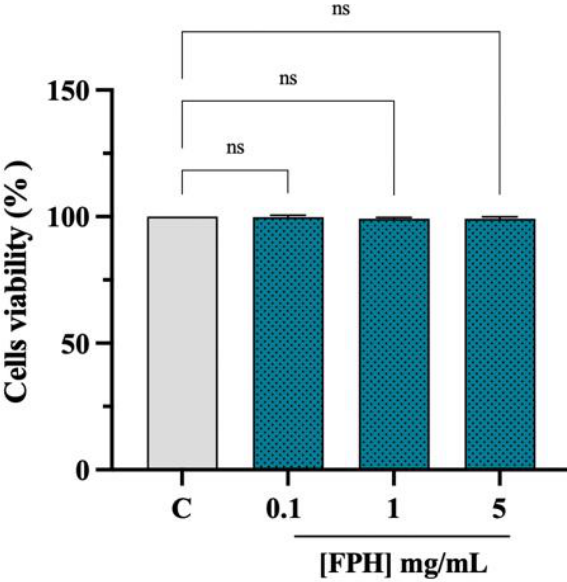
Figure 3. Caco-2 cell viability after FPH treatment. Bar graphs indicating the results of cell viability assay of Caco-2 cells after FPH (0.1 – 5 mg/mL) treatment for 48 h. The data points represent the averages ± SD of three experiments in triplicate, statistical analysis was performed by one-way ANOVA. C: control sample (H 2 O), ns: not significant.